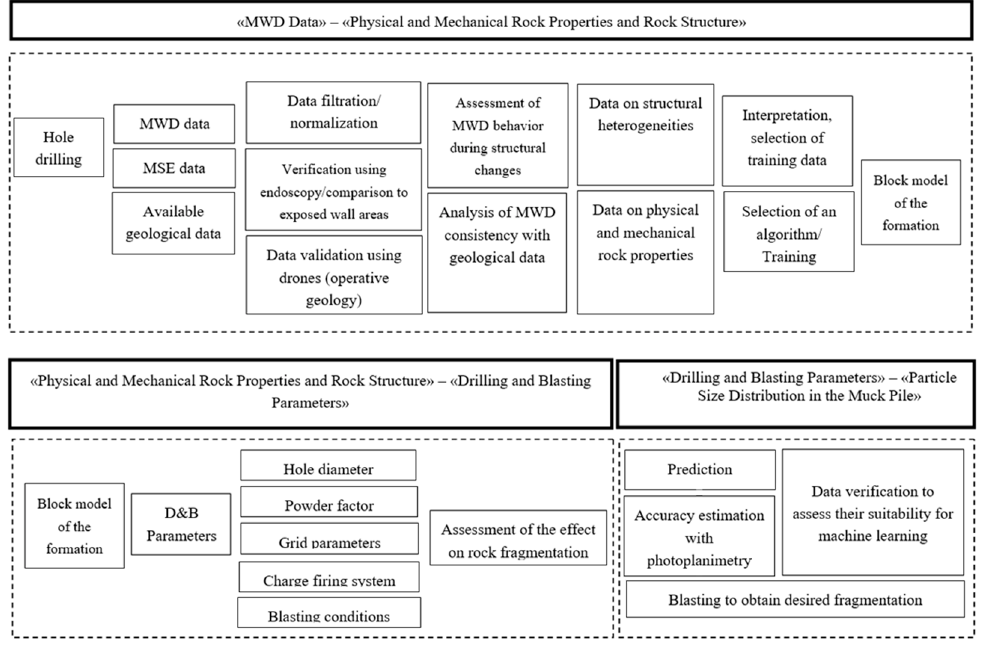
Figure 15. Research concept and future direction of research.